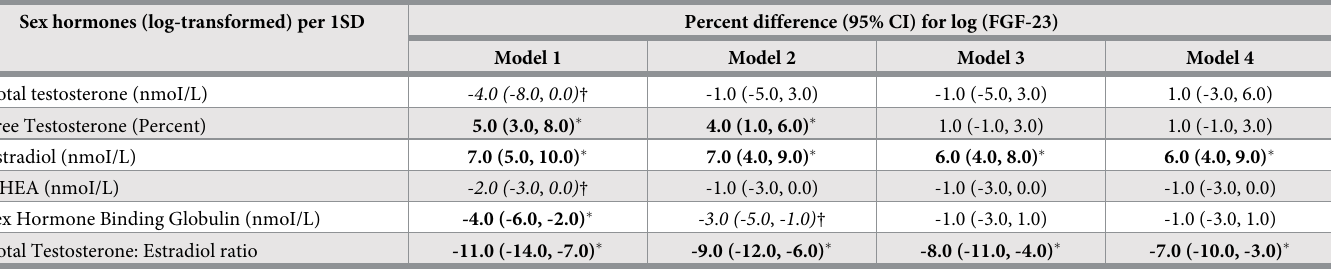
Table 3. Percent difference with 95% CI of the associations between log-transformed endogenous sex hormones and FGF-23 among men, n = 3,052. Sex hormones (log-transformed) per